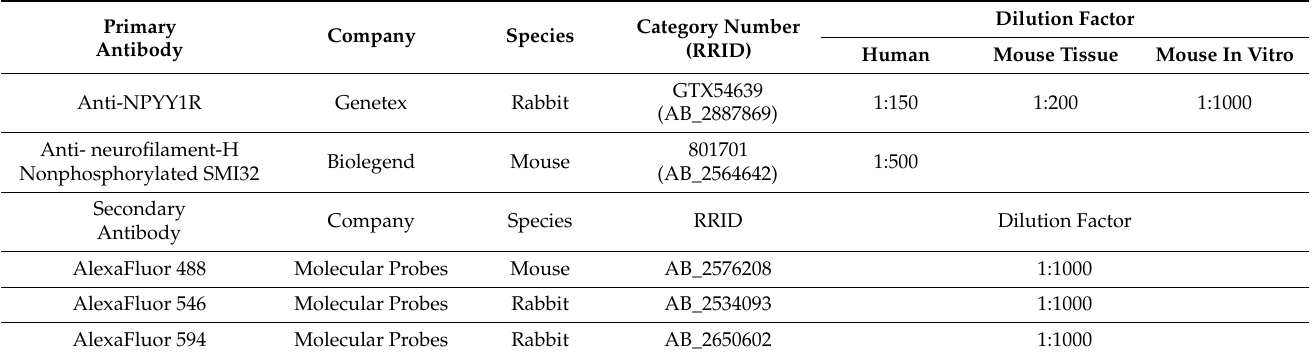
Table 2. Immunohistochemistry primary and secondary antibody